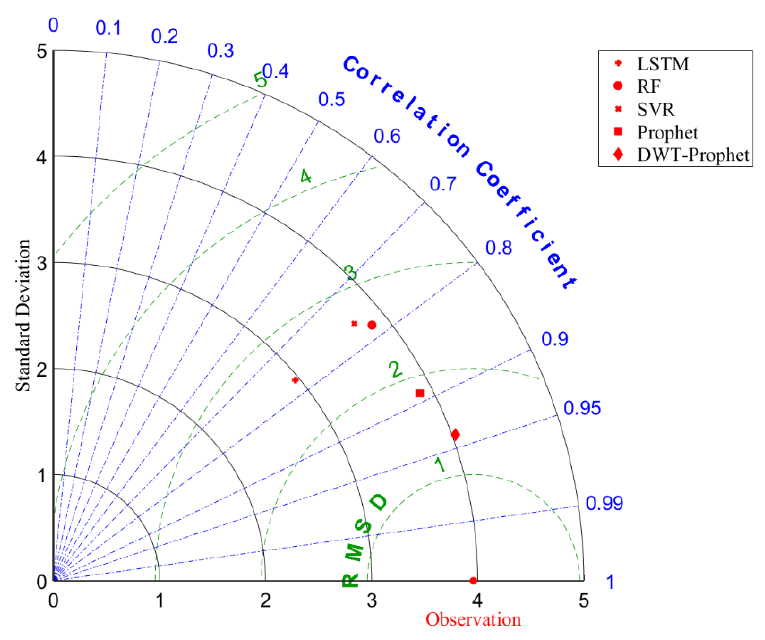
Figure 12. The Taylor diagram of the prediction errors results.